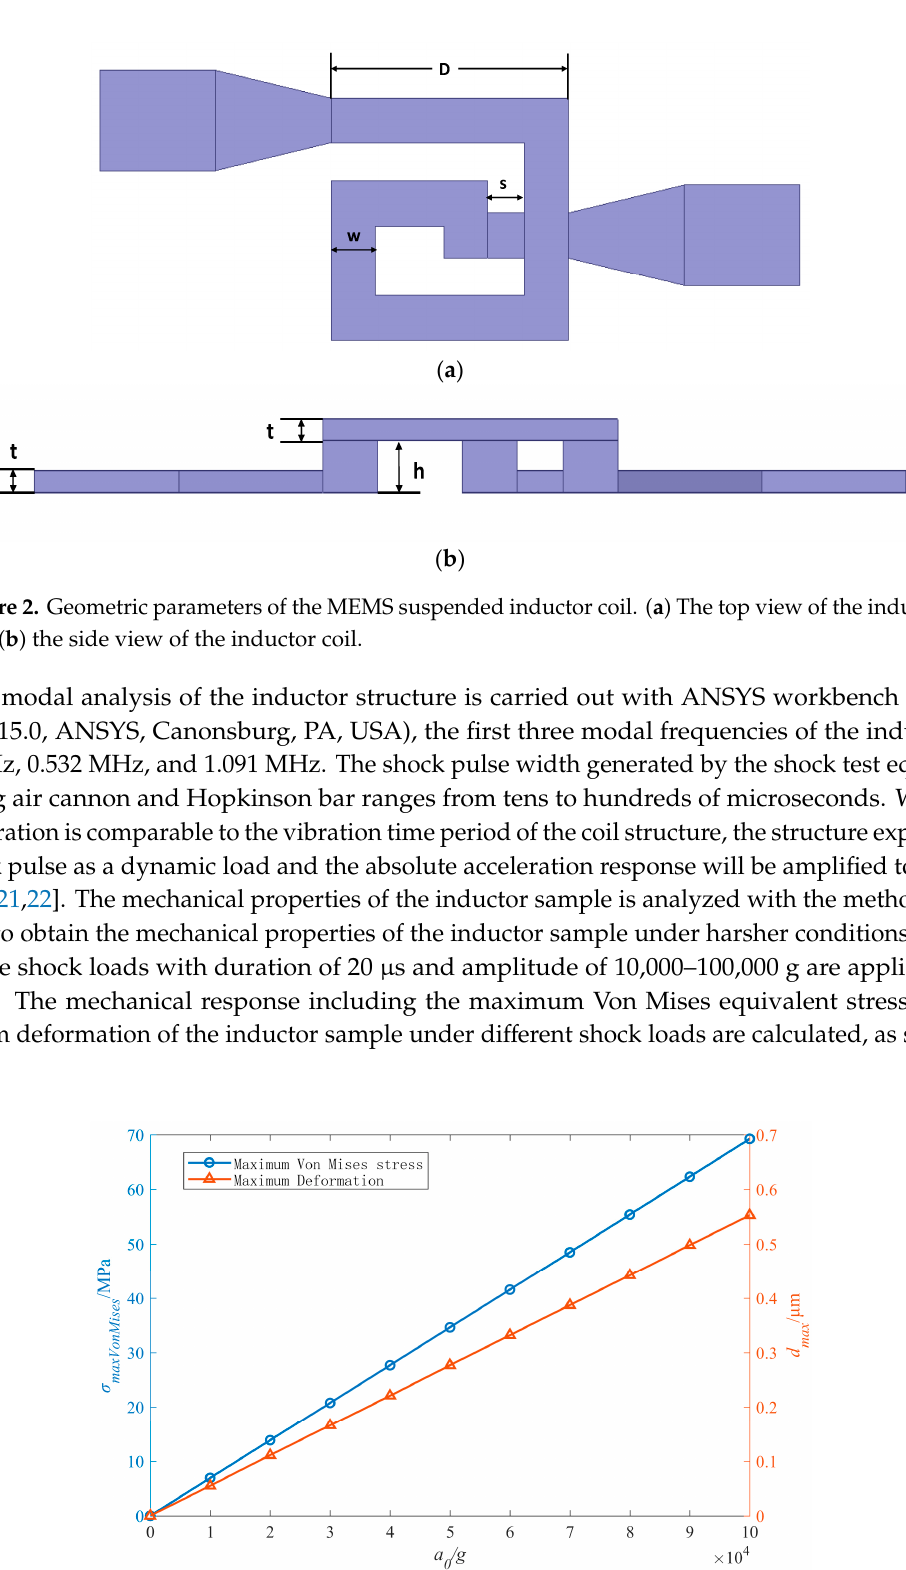
Figure 3. The mechanical response of the inductor sample under shock.